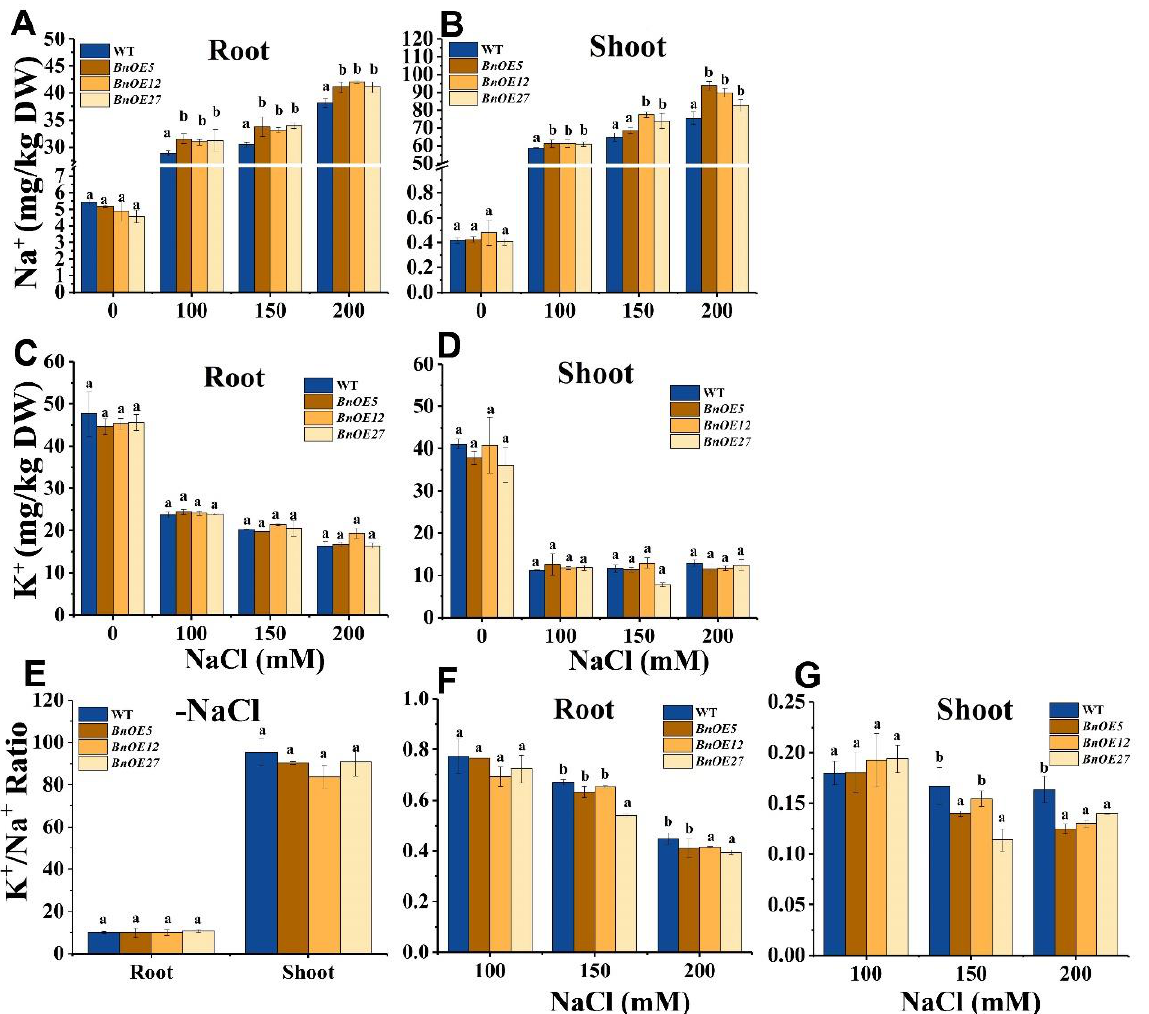
Figure 5. Analysis of the concentration of Na + and K + and K + /Na + ratio of root and shoot in WT and BnOE . ( A , B ): Na + concentration of root and shoot in WT and BnOE . ( C , D ): K + concentration of root and shoot in WT and BnOE . ( E – G ): K + /Na + ratio of root and shoot in WT and BnOE . Ten-day-old wild-type and BnOE plants were treated with NaCl gradient from 0 to 75, 100, 150, and 200 mM or without for 14 days. The root and shoot were harvested and dried at 80 °C for about 24 h. The concentration of Na + and K + of all samples was analyzed using ICP-AES. DW: dry weight. Vertical bars represent mean values ± SD (n = 30 seedlings). Different letters indicate significant differences between three independent experiments (analysis of variance; p < 0.05).